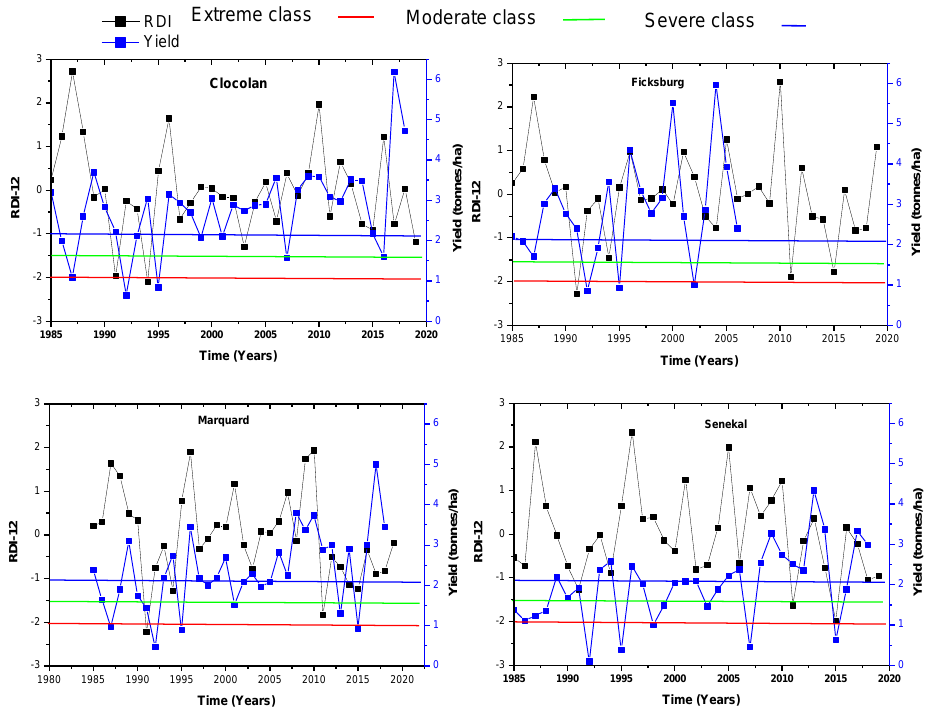
Figure 4. RDI-12 (black trendline) Setsoto municipality drought index (OND) and maize yield (blue trendline) for the period between 1985 and 2019.